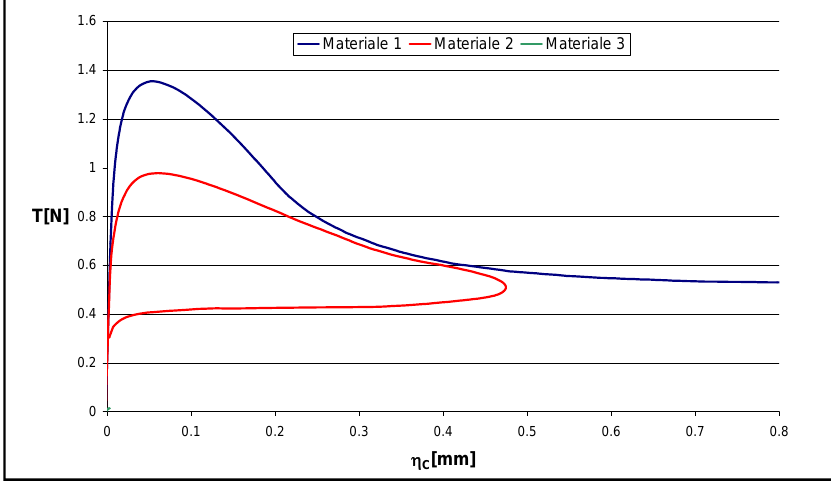
Figura 6: Forza orizzontale totale T in funzione della componente di spostamento  C .